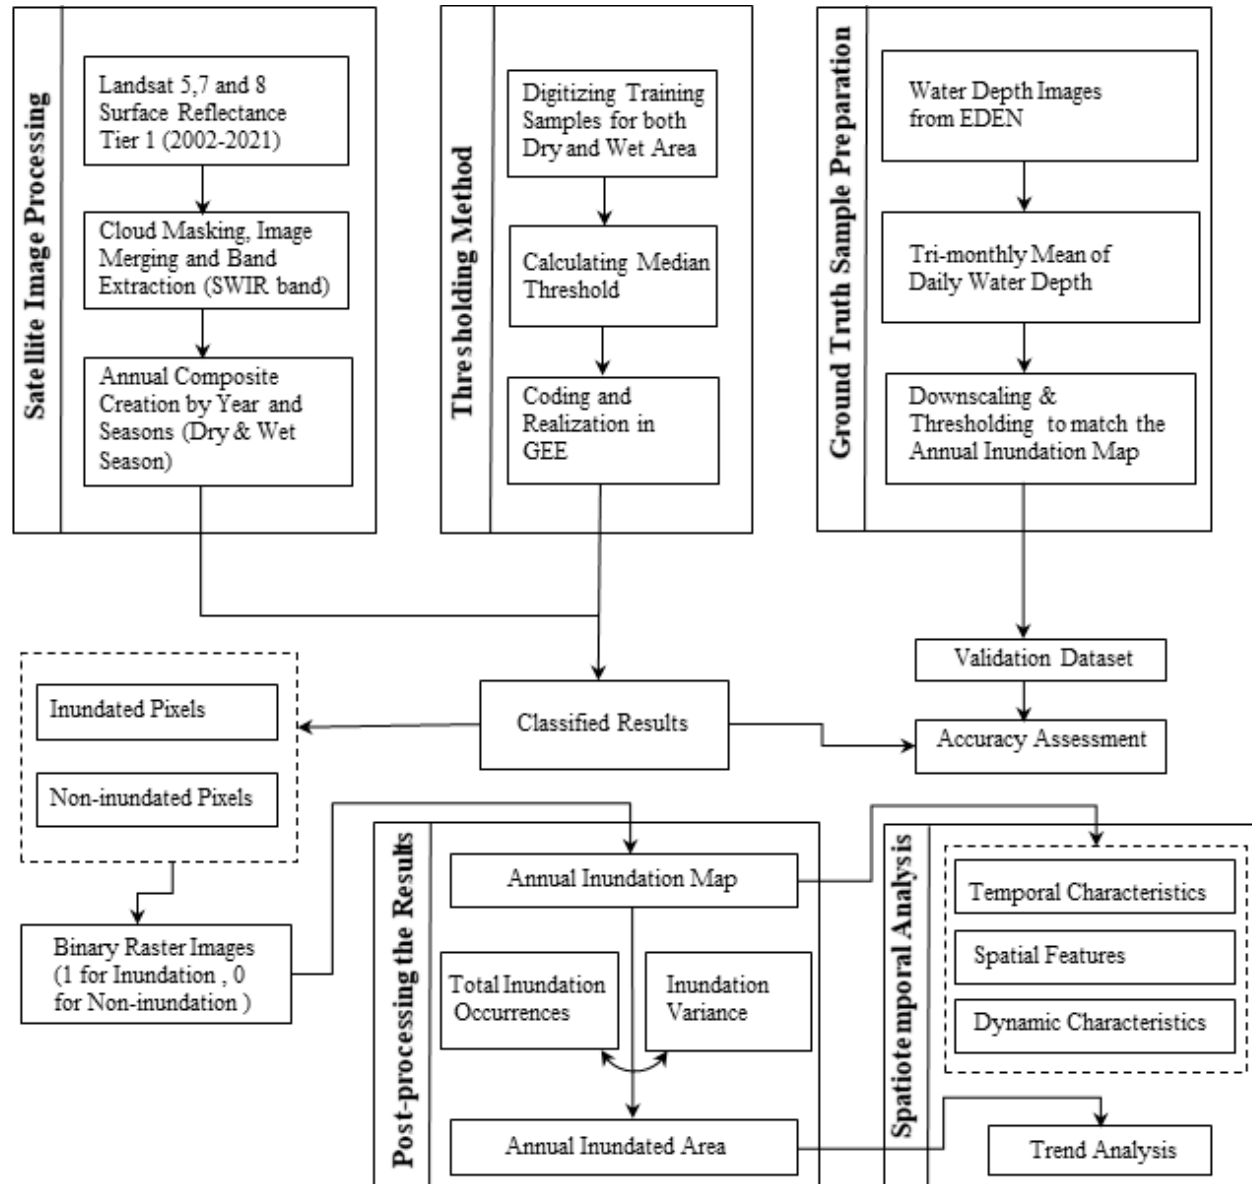
Figure 1. The schematic flowchart displaying the methodology for seasonal inundation dynamics and spatiotemporal analysis in the Everglades from 2002 to 2021.